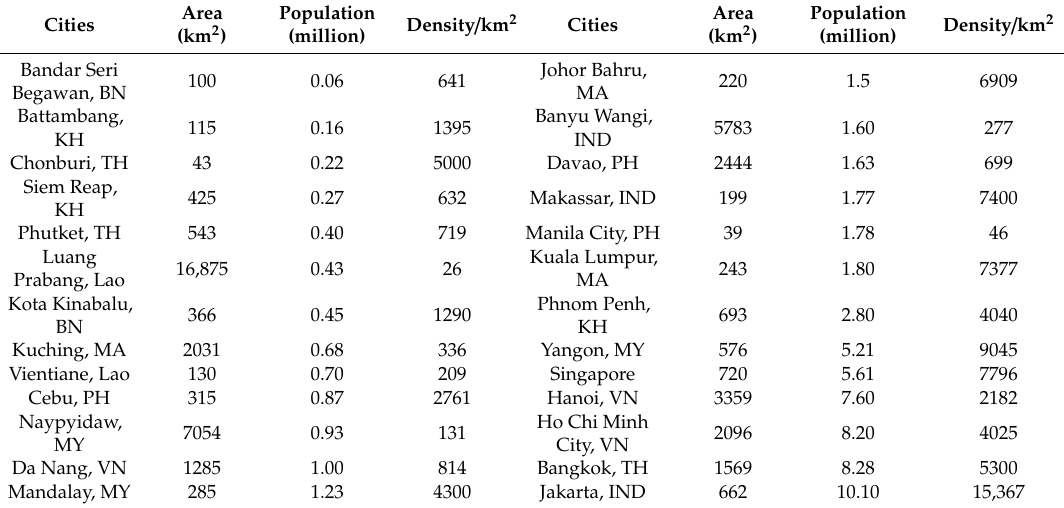
Figure 1. Map of the 26 pilot cities in the Association of Southeast Asian Nations (ASEAN) smart cities network (ASCN) showing their locations in the ASEAN member states. Table 1. Area, population, and density of the 26 pilot cities of ASCN from the least to most populous cities.